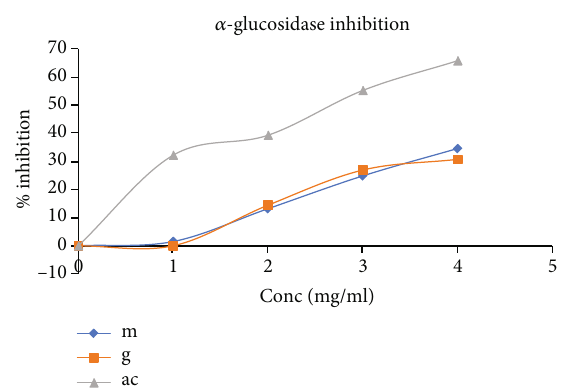
Figure 6: Percentage inhibition of α -glucosidase activity of plant extracts mixture, granules, and acarbose.